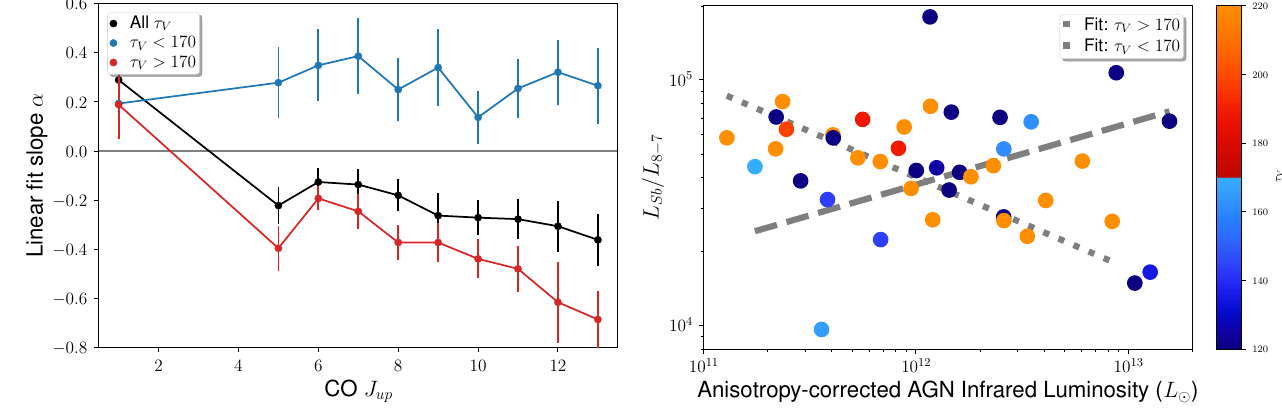
Figure 7. ( Left ) The slopes of the L Sb / L CO vs. L c as a function of CO transition. The slopes are shown for the whole sample, and for the τ V > 170 and τ V < 170 sub-samples. ( Right ) An example of the L Sb / L CO vs. L c are the individual fits for the τ V > 170 and τ V < 170